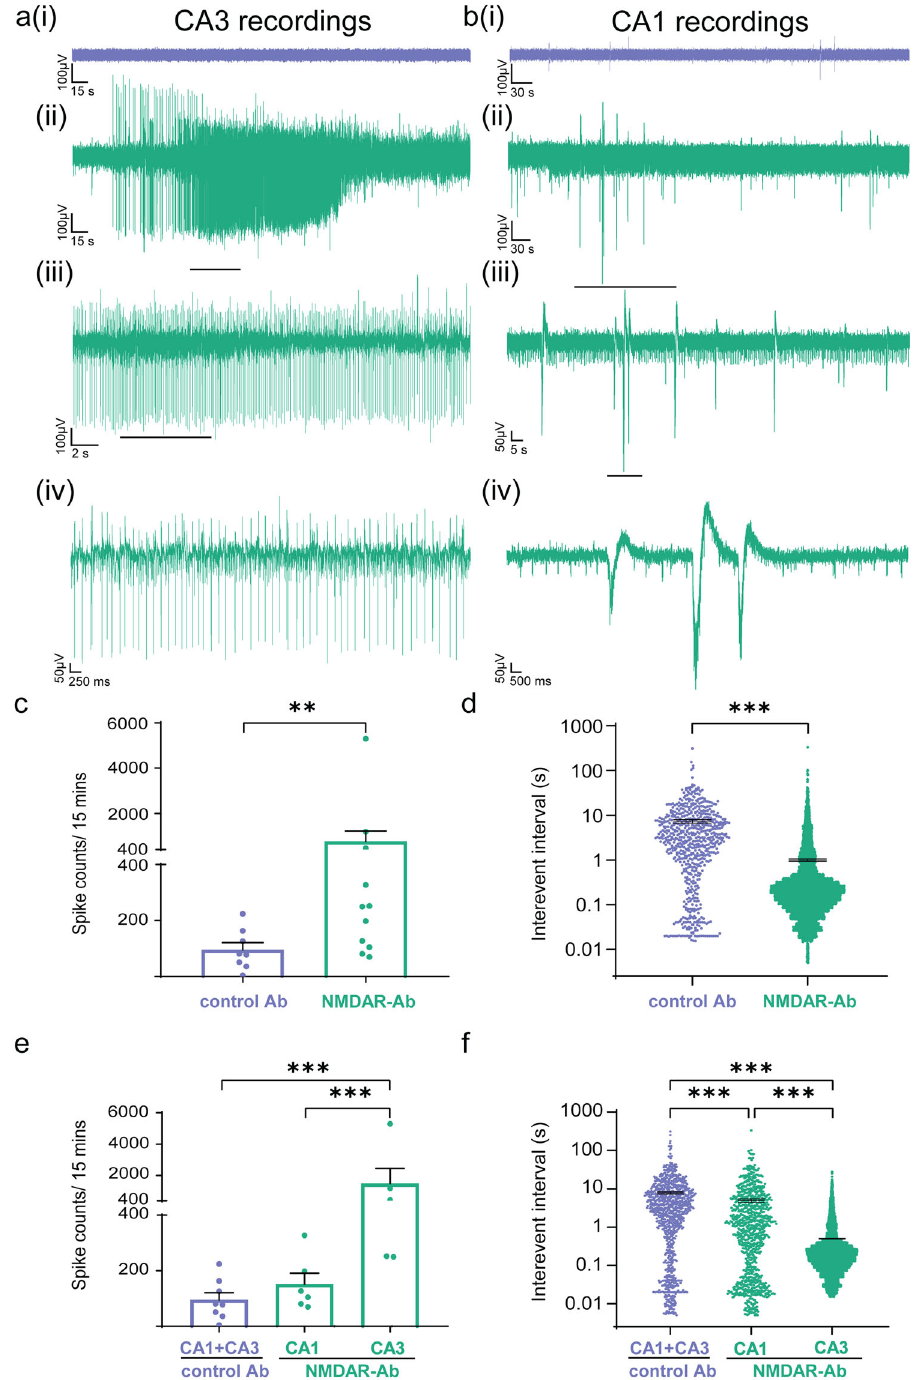
Fig. 1 Hippocampal local fi eld potential recordings in vitro 48 h after intracerebroventricular injection of NMDAR antibodies show spontaneous epileptic activity, highest in the CA3 region. a Example traces of local fi eld potential brain slice recordings from control ( a i) and NMDAR antibody ( a ii – iv) injected animals after 48 h from the CA3 region. Scale bar 100 µ V vs. 15 s (i and ii), 100 µ V vs. 2 s (iii) and 50 µ V vs. 250msec (iv). b Example traces of local fi eld potential brain slice recordings from control ( b i) and NMDAR antibody ( b ii – iv) injected animals after 48 h from the CA1 region. Scale bar 100 µ V vs. 30 s (I and ii), 50 µ V vs. 5 s (iii) and 50 µ V vs. 500 msec (iv). c The number of spikes (interictal events) per 15 min in the NMDAR antibody slices compared to controls (Control ( n = 8 brain slices) vs. NMDA ( n = 11 brain slices); ** p = 0.0065, Mann – Whitney). d The intervent interval (IEI) in control Ab slices compared to NMDAR antibody injected slices (Control ( n = 8 brain slices) vs. NMDA ( n = 11 brain slices); *** p < 0.001, Mann – Whitney). e The number of spikes (interictal events) in the CA3 region of the NMDAR antibody hippocampal slices as compared to CA1 (NMDA CA1 ( n = 6 brain slices) vs. NMDA CA3 ( n = 5 brain slices); *** p < 0.001, Mann – Whitney). f Comparison of IEI between the CA3 and CA1 region in NMDAR antibody hippocampal slices (NMDA CA1 ( n = 6 brain slices) vs. NMDA CA3 ( n = 5 brain slices); *** p < 0.001, Mann-Whitney). Measurements expressed as mean ± standard error of the mean (SEM).